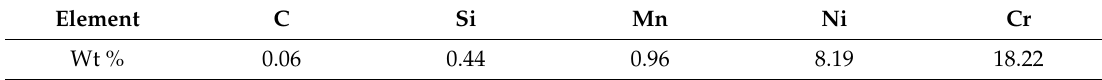
Figure 1. Experimental setup for observing the weld pool surface. Table 1. Chemical composition of base metal (SUS 304).